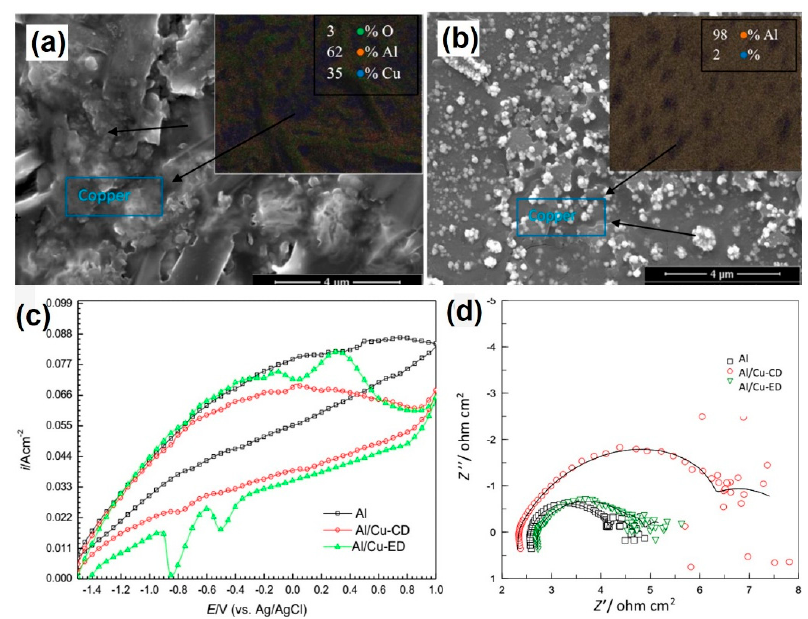
Figure 10. SEM images and EDS maps of ( a ) Al / Cu-CD, ( b ) Al / Cu-ED, ( c ) The cyclic voltammogram in 1 M NaOH of Al (pure), Al / Cu-CD, and Al / Cu-ED, ( d ) EIS measurements of anodes in 1 M NaOH, The Nyquist a Al (pure), Al / Cu-CD, Al / Cu-ED [53] (Copyright © 2018, Springer Nature).